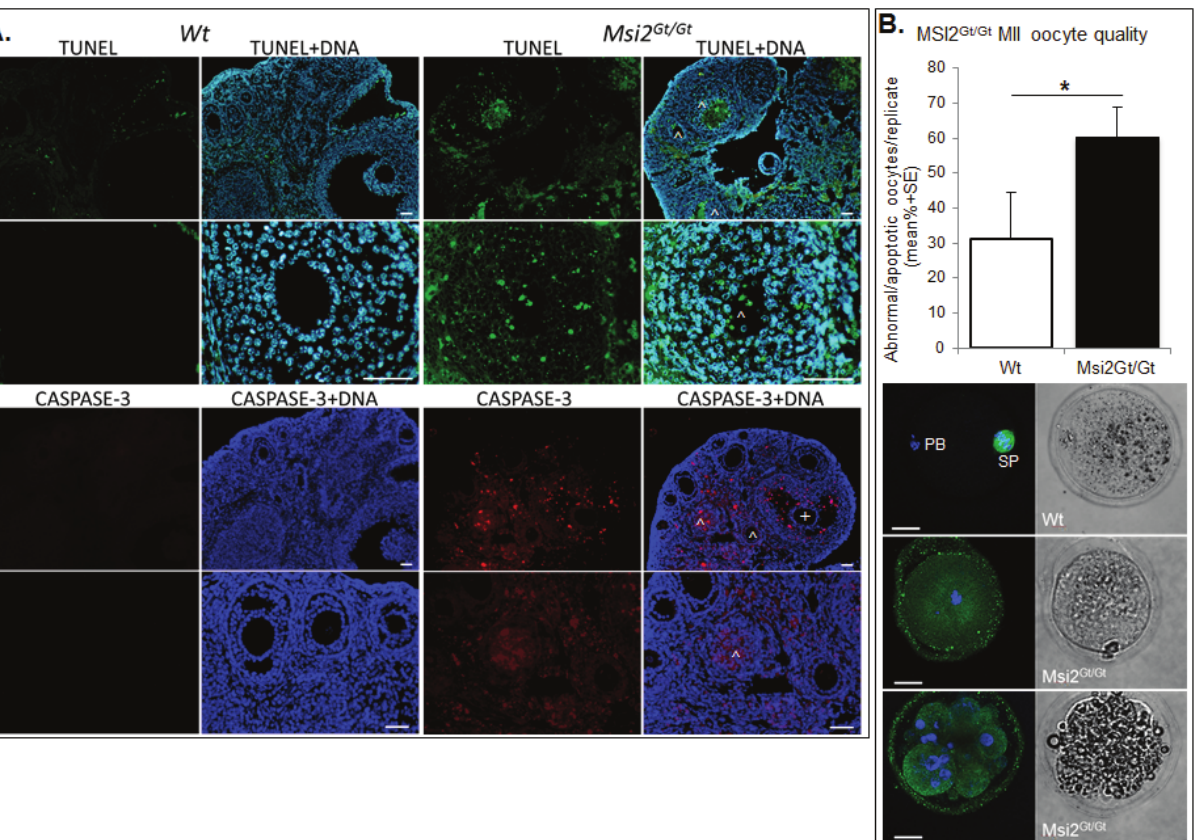
Figure 6. Assessment of Msi2 Gt/Gt ovarian and oocyte health. ( A ) Immunofluorescence of TUNEL and CASPASE-3 in Msi2 Gt/Gt and Wt adult ovary. Representative images demonstrate an increase in TUNEL (green) and CASPASE-3 (red) in Msi2 Gt/Gt pre-antral (^) and antral ( + ) follicles, verified via quantitative analysis n = 4. Scale bar = 50 (cid:3)m; ( B ) Msi2 Gt/Gt and Wt MII oocyte quality. MII oocytes collected from the oviductal ampullae of super-ovulated adult mice were fixed and subjected to immunocytochemistry for (cid:5)-tubulin (green) to identify spindles and Hoechst (blue) to identify polar body DNA and oocyte chromosomes. Representative images show typical MII staining pattern in Wt depicting polar body (PB) formation and normal chromosome and spindle alignment (SP). Msi2 Gt/Gt images depict irregular spindle assembly and chromosome alignment and oocyte apoptosis. n = 3 biological replicates, 3 mice/replicate, *: denotes p < 0.05. Scale bar = 20 (cid:3)m. The fertility of Msi2 Gt/Gt mice was assessed using sperm-zona pellucida (ZP) binding assays and through randomized breeding trials. Msi2 Gt/Gt oocytes demonstrated a significant 33.9% decrease in the binding of control spermatozoa to the MII oocyte ZP in vitro compared to Wt oocytes ( p (cid:4) 0.001), representing a reduction in fertilization potential (Figure 7A). Adult Msi2 Gt/Gt females exhibited a 33.2% decrease in average litter size generated from randomized breeding trials with Wt males (Figure 7B). This was a significant reduction from control Wt/Wt crosses ( p <